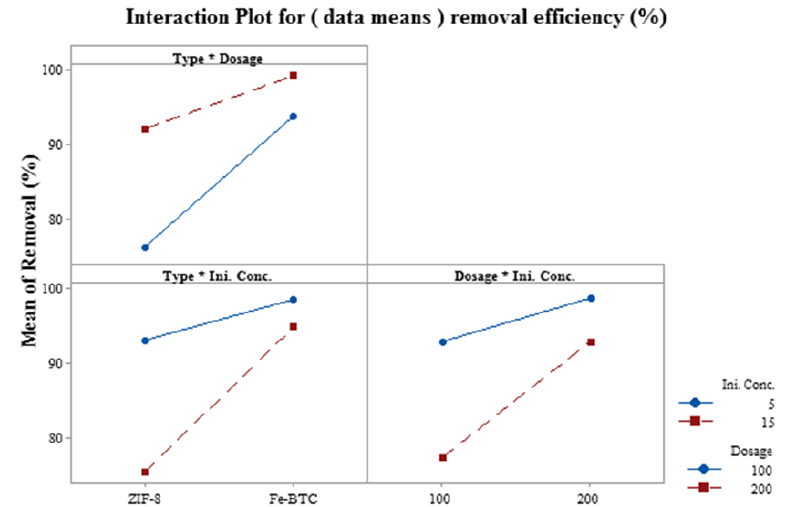
Figure 11. Interaction effects plot for MO removal efficiency.